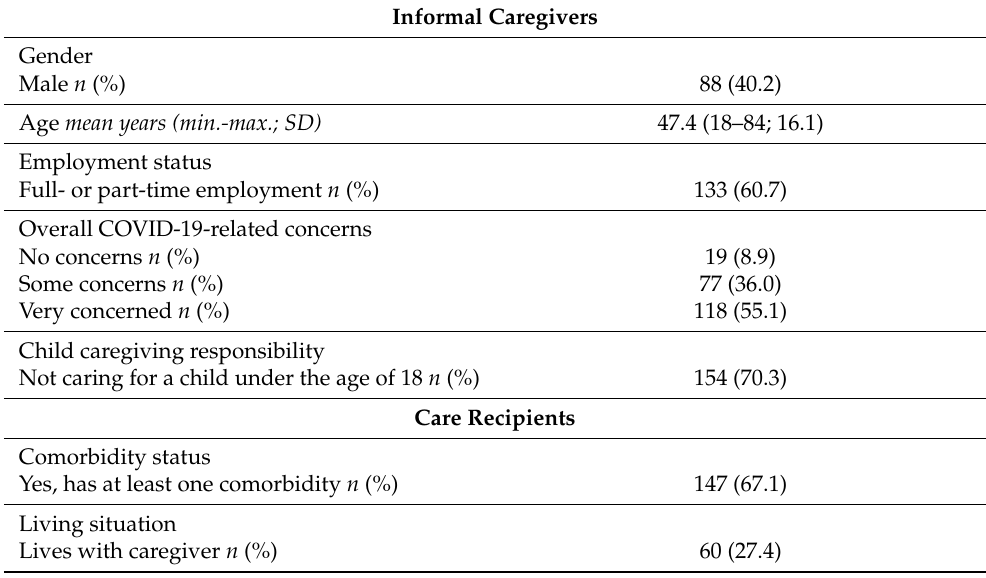
Table 1. Socio-demographic Characteristics of Informal Caregivers and Care Recipients ( n =